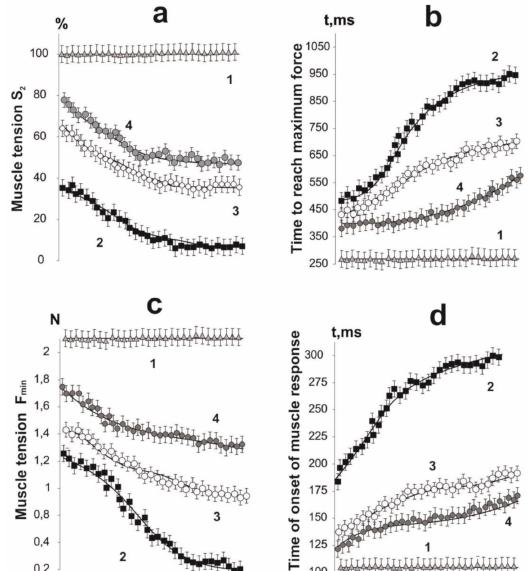
Figure 4. Parameters of single contractions of muscle soleus rat after chronic intoxication with glyphosate for 30 days, caused by 5 s stimulation with a frequency of 50 Hz: ( a ) integrated muscle power (S 2 ), calculated from the total area of the force curves as a percentage of the control values; ( b ) time to reach the maximum force response; ( c ) minimum (F min ) fixed force of muscle contraction; ( d ) time of onset of muscle response to stimulation. 1—control group (native muscle); 2—the glyphosate group; 3—the glyphosate+C 60 fullerene (0.5 mg/kg) group; 4—the glyphosate+C 60 fullerene (1 mg/kg)